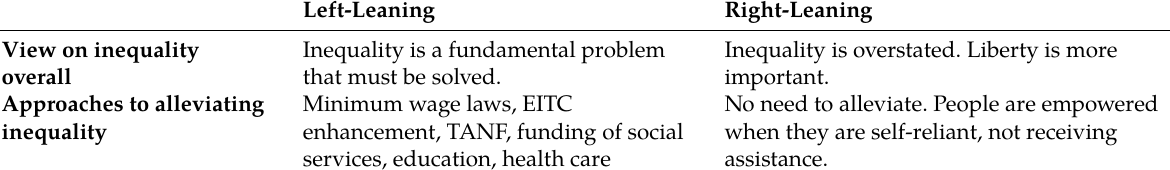
Table 7: Partisan think tank verbiage differences. Left-Leaning